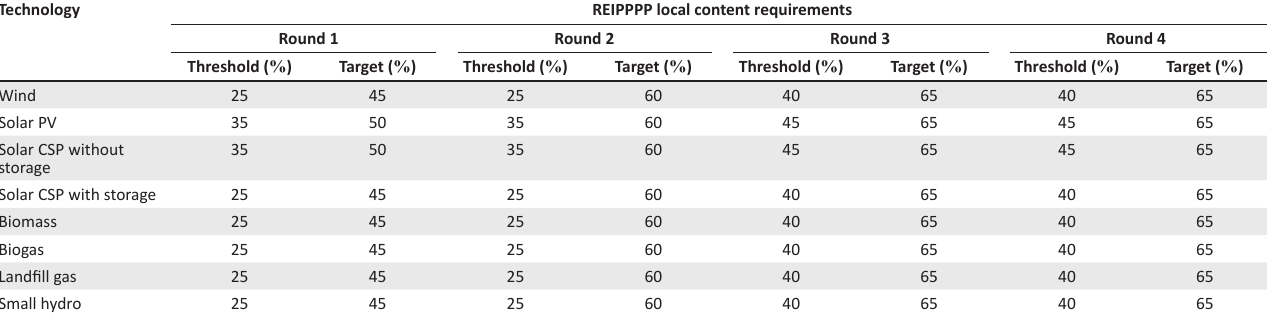
TABLE 2: REIPPPP local content requirement percentage levels.